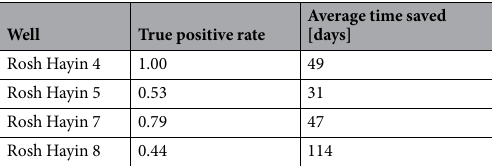
Table 3. Energy Algortihm Results.